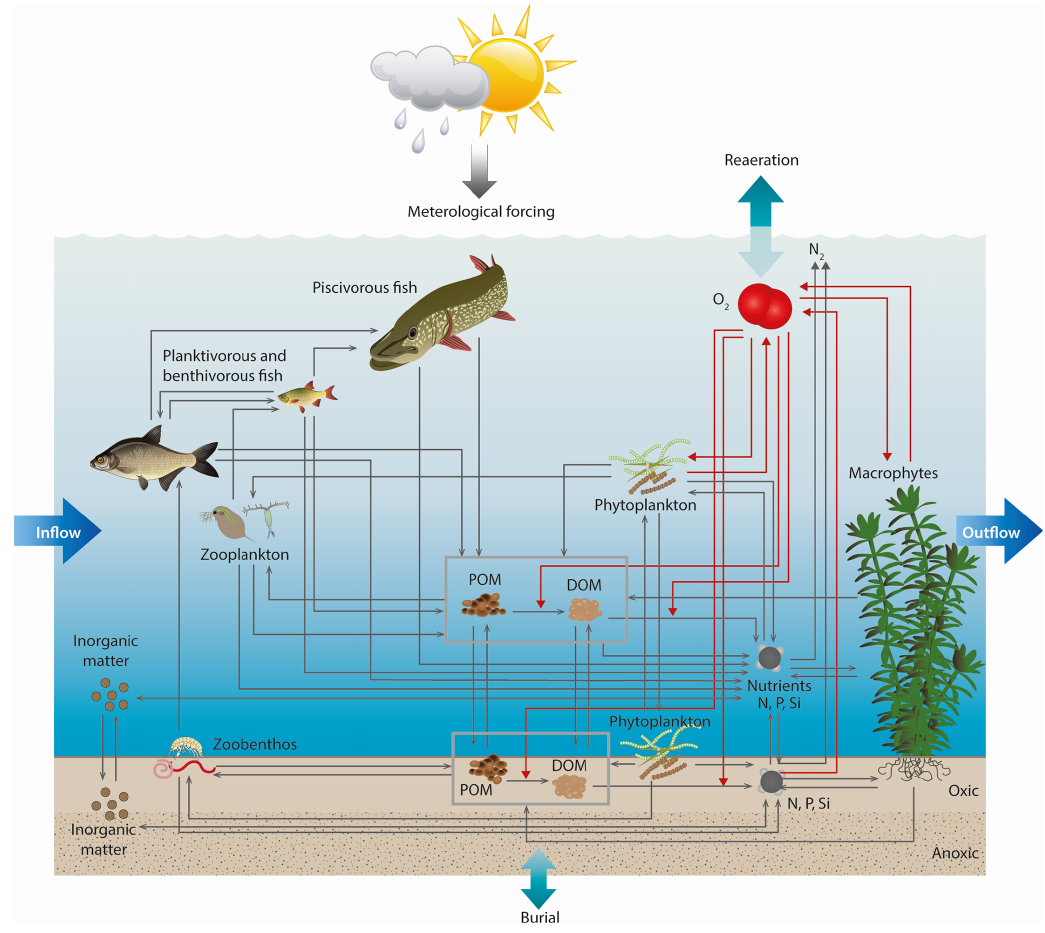
Figure 1. The conceptual model of WET in a setup similar to the ones of 0D PCLake and 1D GOTM–FABM–PCLake. Grey arrows indicate fluxes of matter (dry-weight, nitrogen, phosphorous or silica) between ecosystem pools, and red arrows indicate oxygen uptake and production. Adapted from Hu et al.